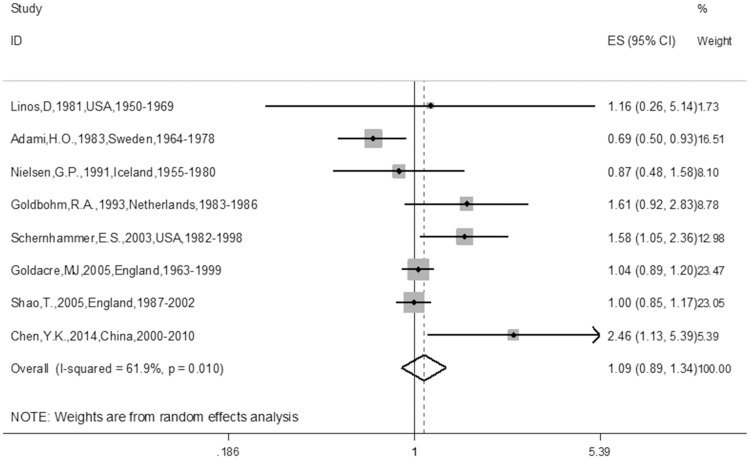
Forest plot of risk of RC associated with cholecystectomy in general population.Note: RC represents rectum cancer.